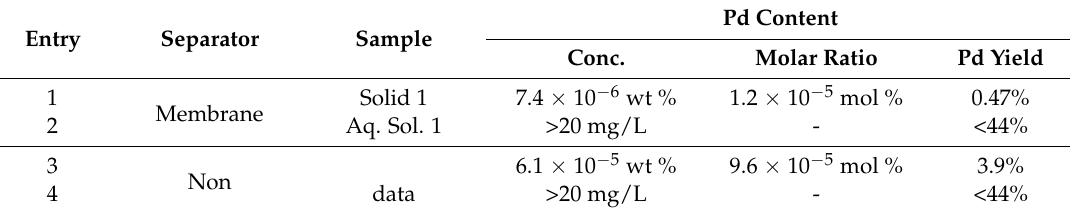
Figure 5. Schematic diagram of ( a ) membrane separation of reaction solution into organic phase and aqueous phase and ( b ) without separator. Table 2. Membrane separation of the reaction solution 1